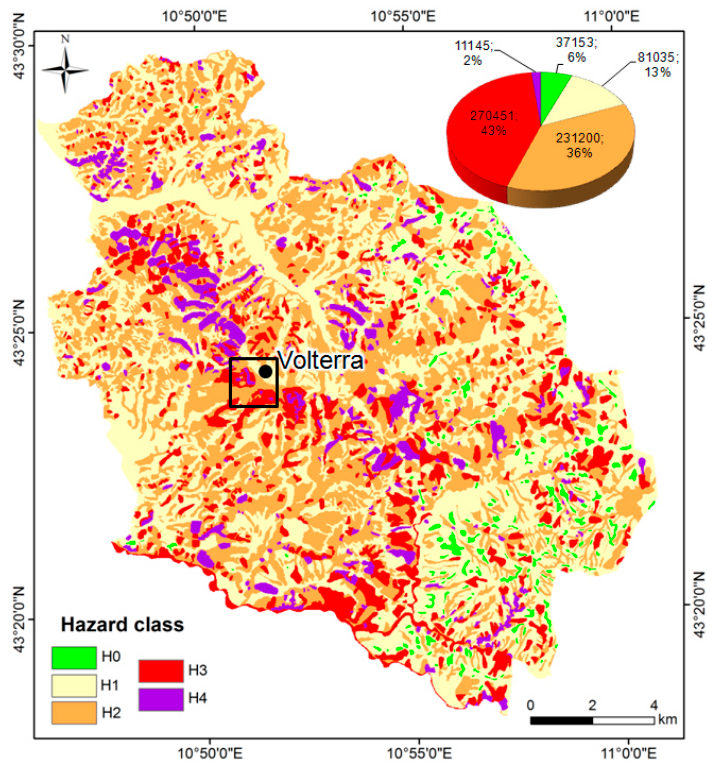
Figure 4. Susceptibility map after GEOPROGETTI [41]. The pie chart shows number of pixels and related percentage for each Susceptibility class. The box with black line shows the location of close-up area of Figure 5.